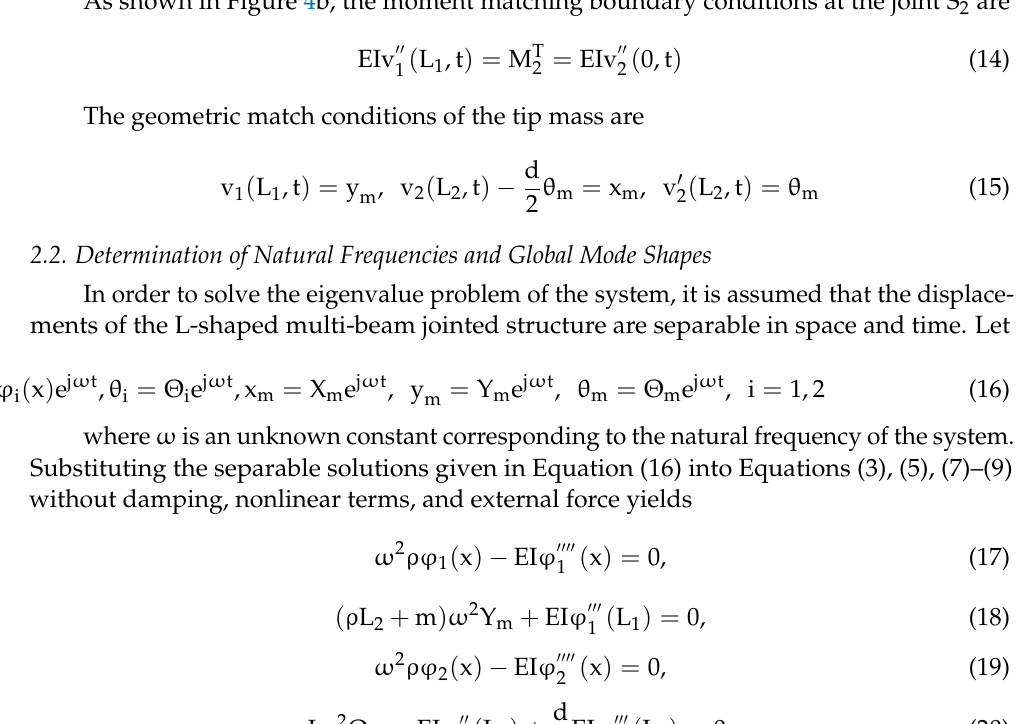
M are the bending moments acting on the joint v